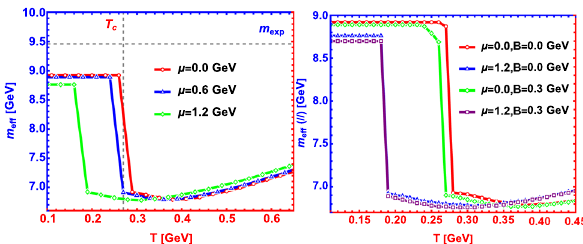
Fig. 10 Left: The effective mass of ϒ( 1 S ) state for different chemical potential μ at B = 0GeV. Right: The effective mass of ϒ( 1 S ) state for the simultaneous effects of B and μ in the case of magnetic field parallel to polarization